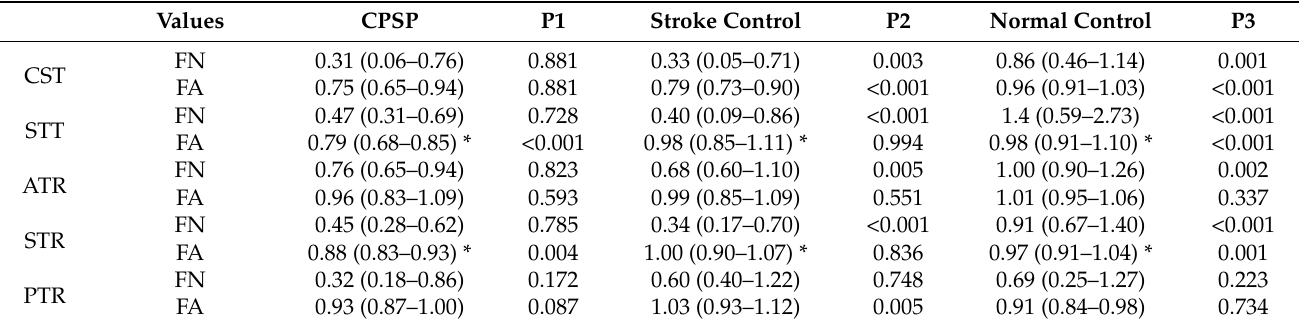
Table 2. FN, FA values of CST, STT, ATR, STR, PTR by group.